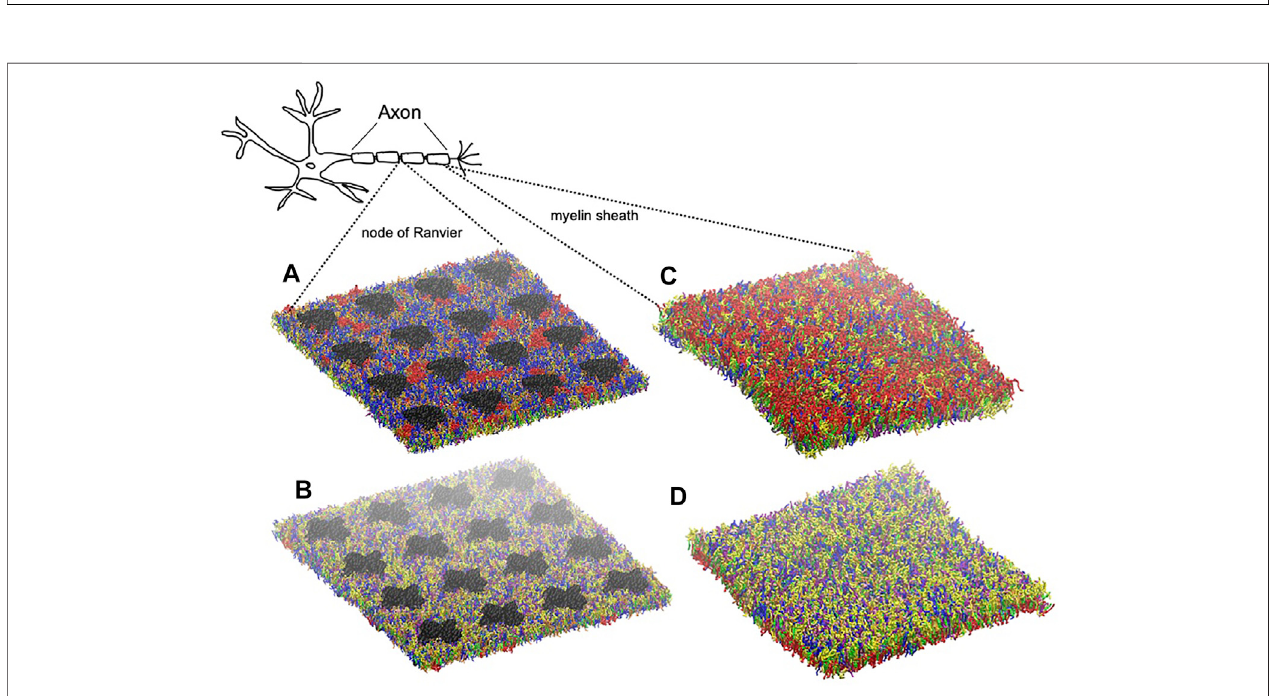
FIGURE 2 | Graphical representation of node-of-Ranvier bilayer model (70 nm) at 16 μ s (A, B) and myelin bilayer model (40 nm) at 25 μ s (C, D) together with a drawofaneuron. Both upand down lea fl ets areshown. Molecules arecolored asfollows: PClipidsare inblue, PEinyellow,CHOL ingreen, SM inorange, PSinpurple, glycolipids in red, anionic lipids in pink, the rest of lipids in gray, protein in black VDW representation, and water is not visualized for clarity.